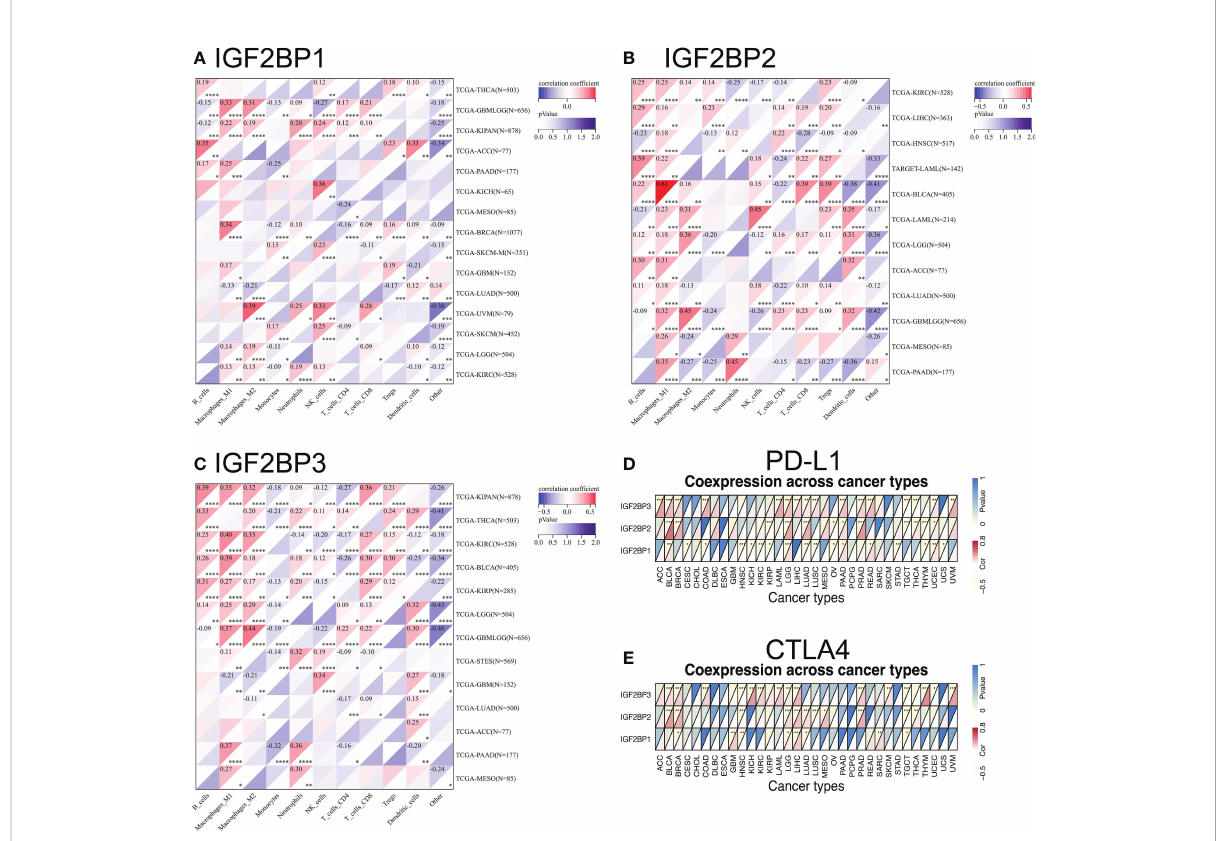
FIGURE 6 Relationship between IGF2BPs and the expression of tumor-in fi ltrating immune cell and immune checkpoint inhibitors. (A-C) Heatmap representation of the correlation between IGF2BPs expression and immune cell in pan-cancer. (D, E) Heatmaps represent the association of the IGF2BPs expression with PD-L1 and CTLA4. *P < 0.05, **P < 0.01, ***P < 0.001, ****P <